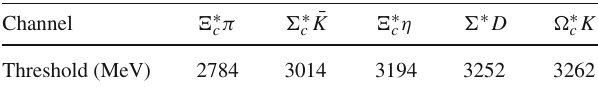
Table3 Charmsectorchannelswith J P = 3 / 2 − andrespectivethresh-